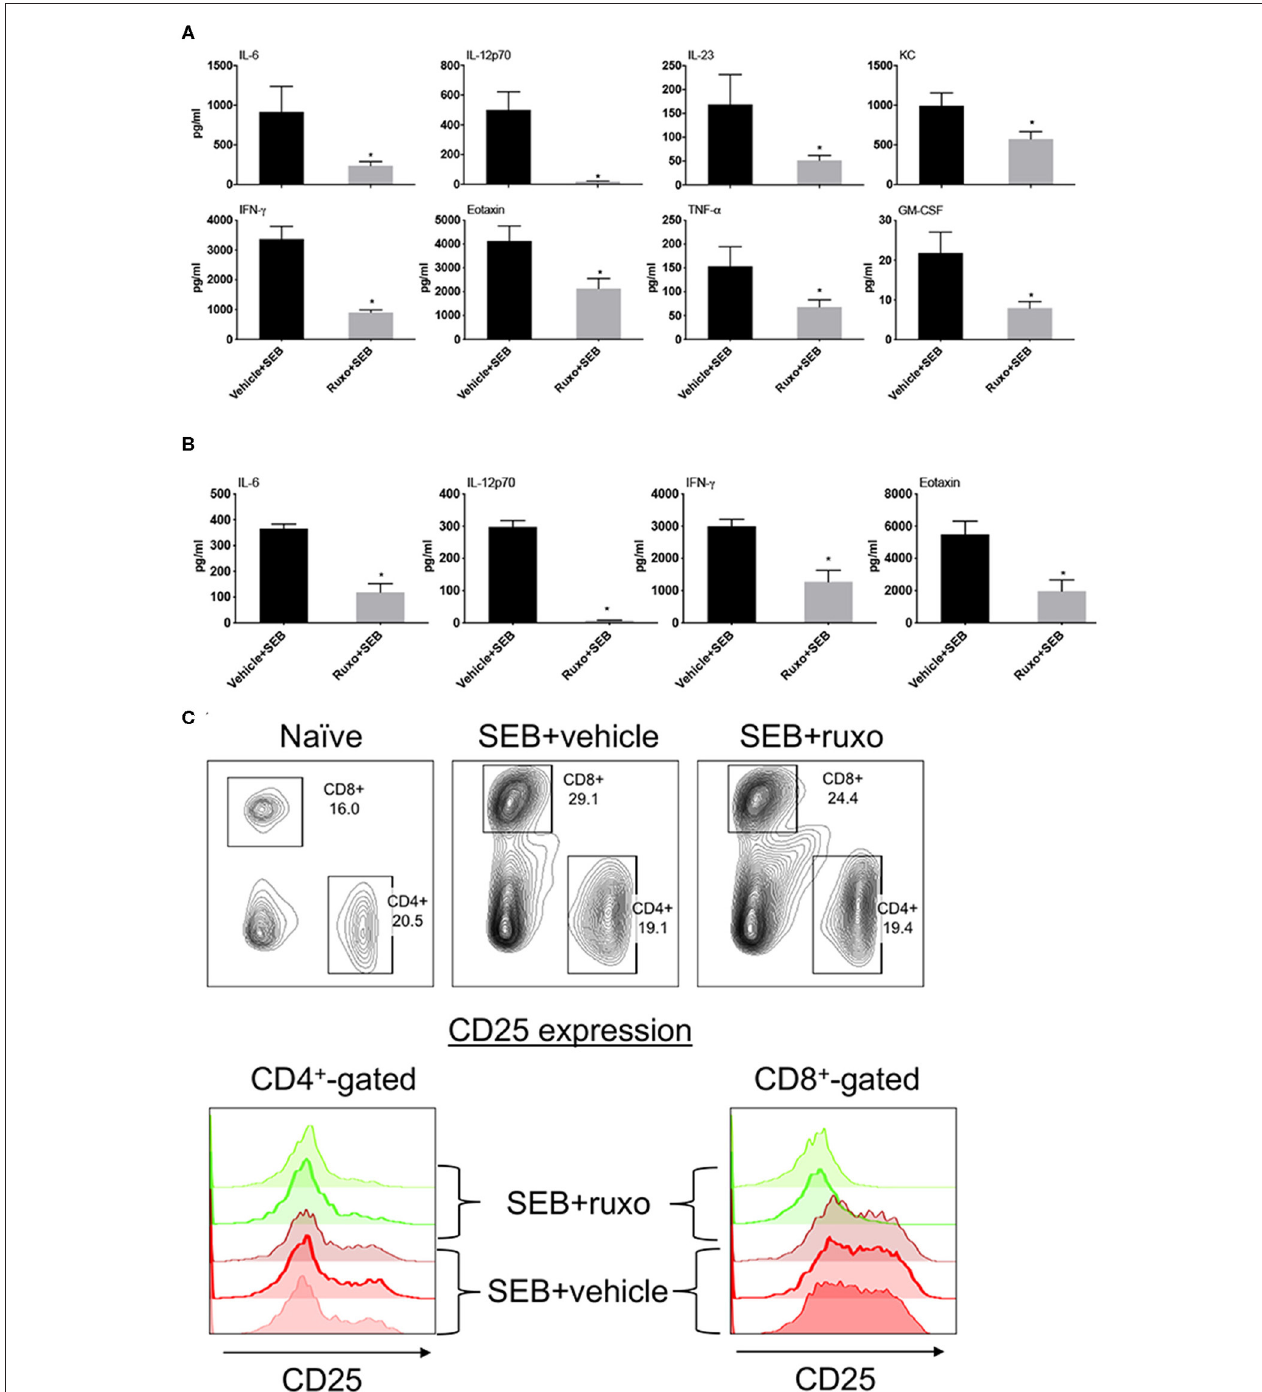
FIGURE 10 | Ruxolitinib inhibits SAg-induced cytokine production and T activation in vivo . Age-matched HLA-DR3 transgenic mice were challenged with SEB (50 µ g in 200 µ l of PBS by intraperitoneal route). Mice were either pretreated with ruxolitinib or vehicle prior to SEB challenge as described in methods (A) or treated with ruxolitinib or vehicle immediately after intraperitoneal SEB challenge (B) . Animals were sacrificed 4h after SEB challenge and the concentrations of cytokines/chemokines in individual serum samples were determined using multiplex assay kits. Only cytokines/chemokines that are significantly different between the two groups are shown for clarity. Bars represent mean ± SE from 4 to 6 mice. * p < 0.05 by unpaired t -test. (C) Mice were gavaged twice daily with ruxolitinib or vehicle from a day prior to SEB until the time of sacrifice. The animals were euthanized 48h later. Spleens were harvested cells, mononuclear cells were isolated as per standard procedure, washed, and stained with indicated antibodies. The expression of CD25 on CD4 + and CD8 + -gated splenocytes was determined by flow cytometry. Representative dot plots and histograms are shown.